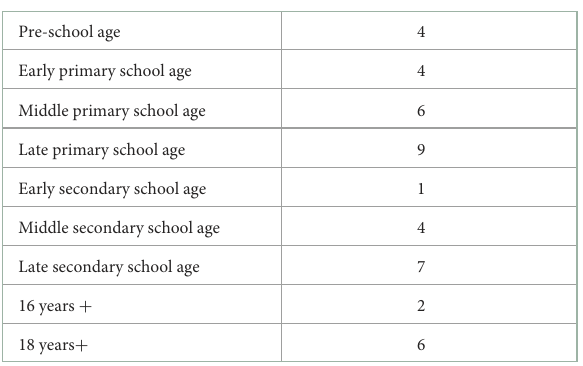
TABLE 7 Age groups of children across the parental